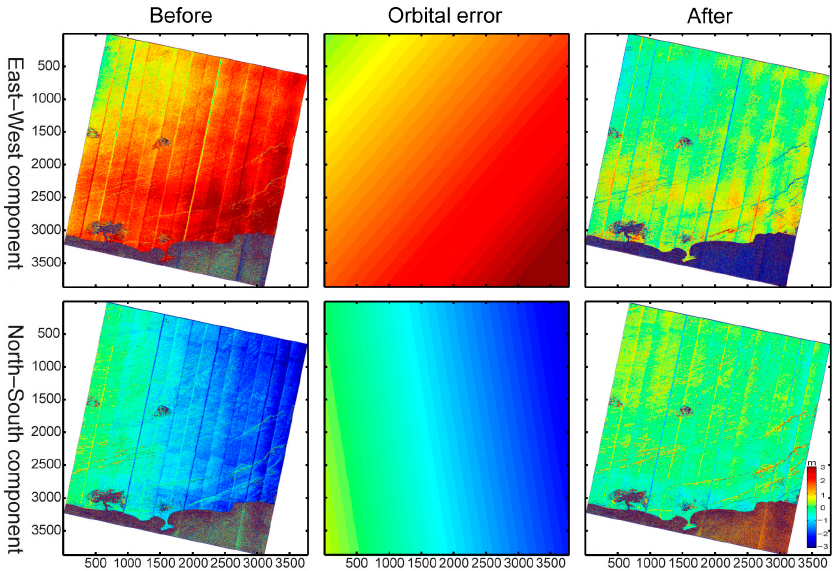
Figure 4. E/W and N/S components of image deformation field before and after removing the orbital error, taking the correlation image pair 29 November 2013–15 December 2013 as an example.